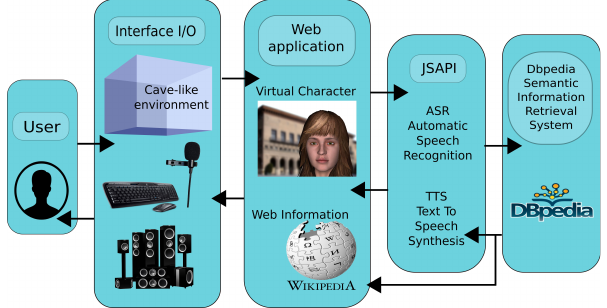
Figure 4. Conversational Character